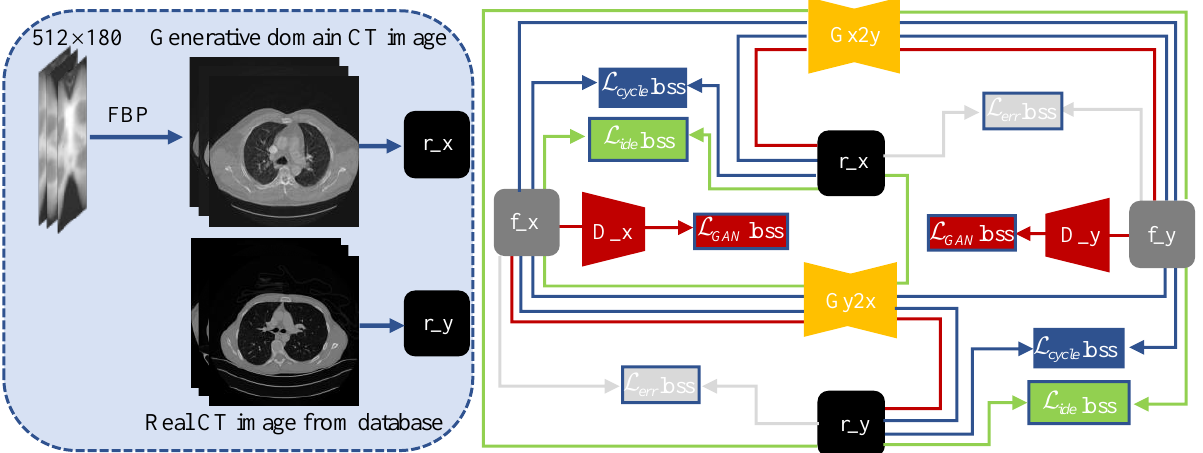
Figure 3. Dataset and AR-GAN framework. The dataset is in the box on the left in the figure and AR-GAN framework is on the right. The two yellow polygons represent the generator, the two red trapezoids represent the discriminator, different colored rectangles represent different loss functions, different colored lines represent different loss paths, and the squares represent the image domain.